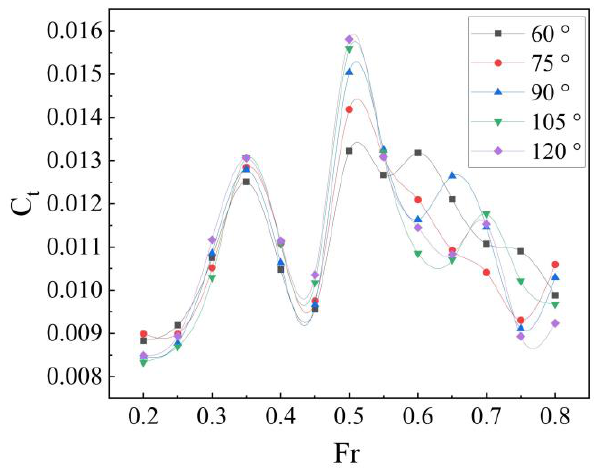
Table 6. Fr corresponding to the ship speed V.